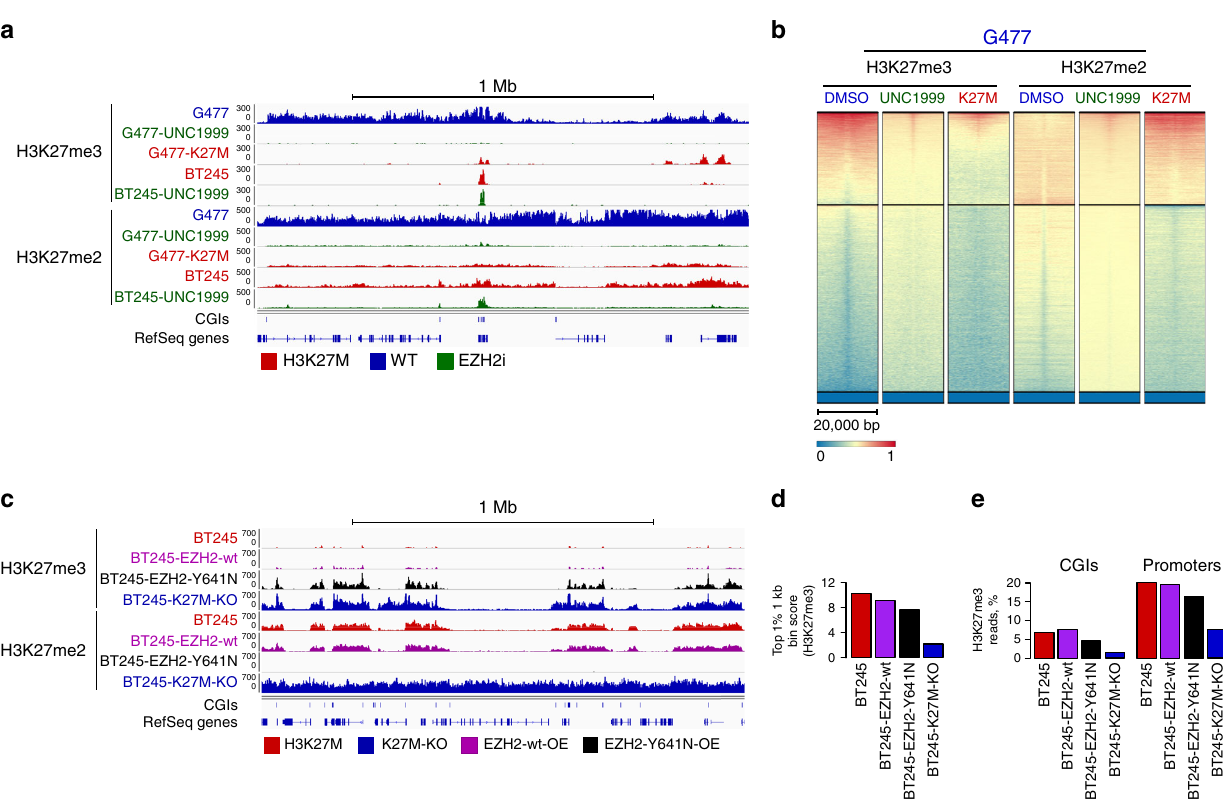
Fig. 3 EZH2 inhibition does not completely mimic H3K27M effects and EZH2-Y641N partly overcomes H3K27M-induced effects ( a , b ). Changes in H3K27me2/3 levels and distribution upon EZH2 inhibition. a Example ChIP-seq tracks of H3K27me2/3 distribution in G477 (wild-type) and BT245 (H3K27M) cell lines treated and not treated with UNC1999 (EZH1/2 inhibitor), ChIP-Rx normalized. For comparison, G477 cell line with H3.3-K27M overexpression is also included. b Heatmap plots of ChIP-seq signal intensity for H3K27me2 and H3K27me3 over CGIs for G477 cell line (wild-type) treated and not treated with UNC1999, as well as with H3.3-K27M overexpression. CGIs are separated by kmeans clustering ( k = 3). c – e Changes in H3K27me2/3 levels and distribution upon overexpression of EZH2-wt and EZH2-Y641N. c Example ChIP-seq tracks (ChIP-Rx normalized) of H3K27me2/ 3 distribution in BT245 cell line (H3K27M) overexpressing wild-type or Y641N mutant forms of EZH2. Parental BT245 and CRISPR-edited K27M-KO clone are included for comparison. d Average enrichment at the top 1% of 1 kb bins for H3K27me3. e Proportion of H3K27me3 reads in CGIs and promoters